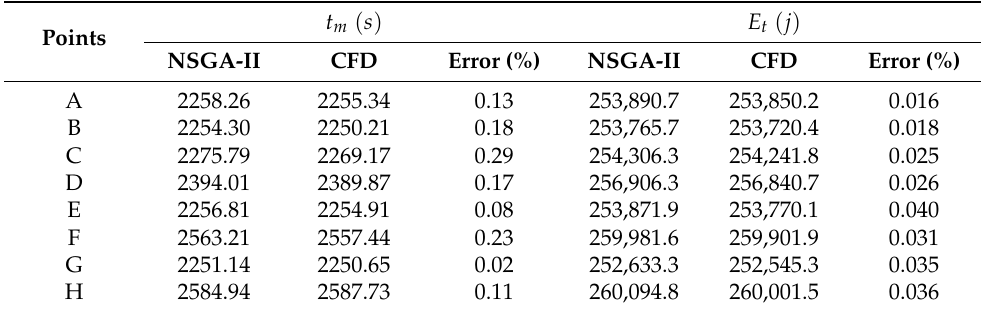
Table 7. Deviation index for MCDM methods.